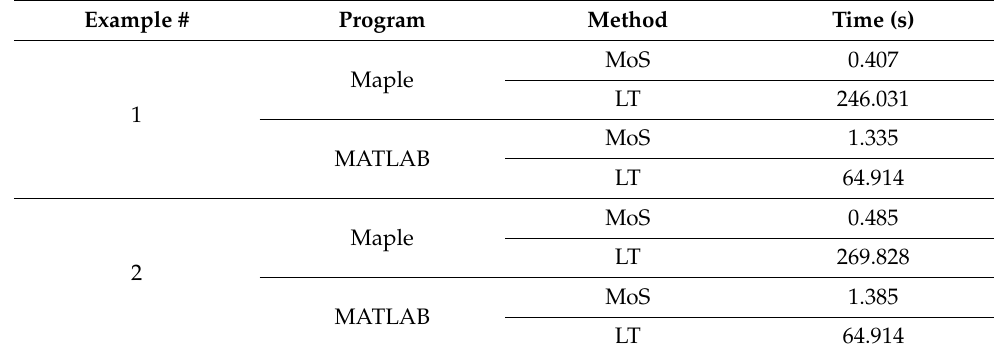
Table 1. Computation time comparison for the non-neutral systems in Equations (19) and